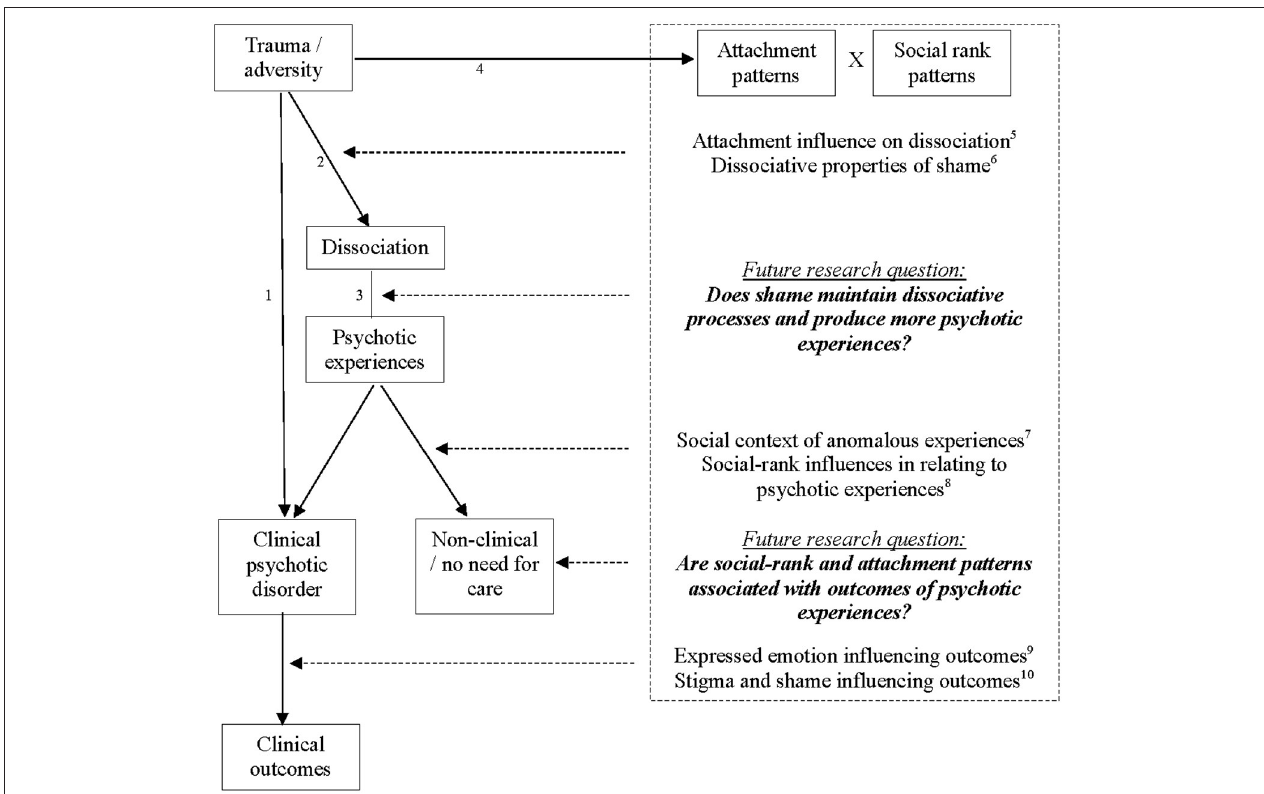
FIGURE 1 | Social influences on the trauma pathway to psychosis. 1 Trauma relationship with psychosis (1); 2 Trauma relationship with dissociation (28, 107); 3 Dissociation relationship with psychotic experiences (108, 109); 4 Trauma relationship with attachment (20, 23) and social rank/shame (60, 64, 99) in psychosis; 5 Liotti (106) and Berry et al. (22); 6 Matos and Pinto-Gouveia (101) and Dorahy et al. (100); 7 Heriot-Maitland et al. (49) and Brett et al. (53); 8 Gilbert et al. (71) and Birchwood et al. (72); 9 Bebbington and Kuipers (110) and Onwumere et al. (111); 10 Turner et al. (74), Upthegrove et al. (75), and Keen et al.